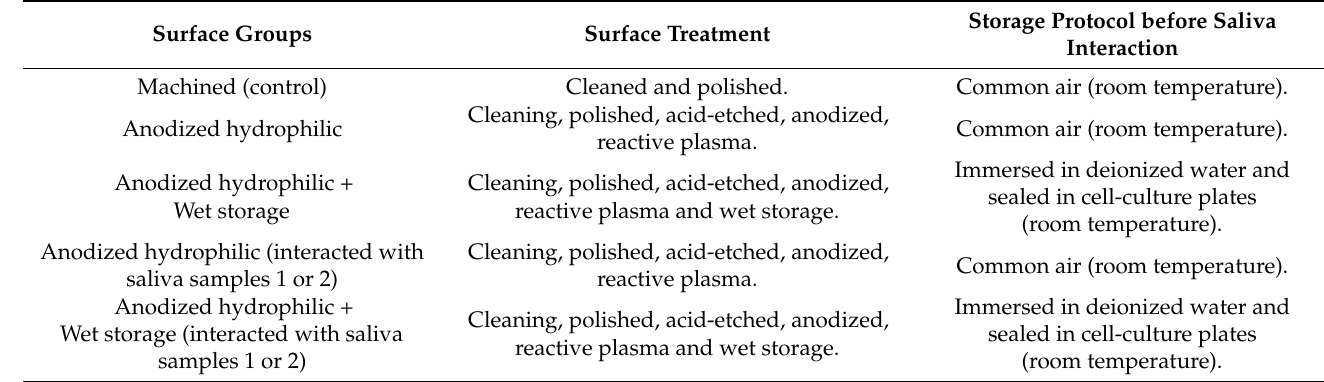
Storage Protocol before Saliva Interaction